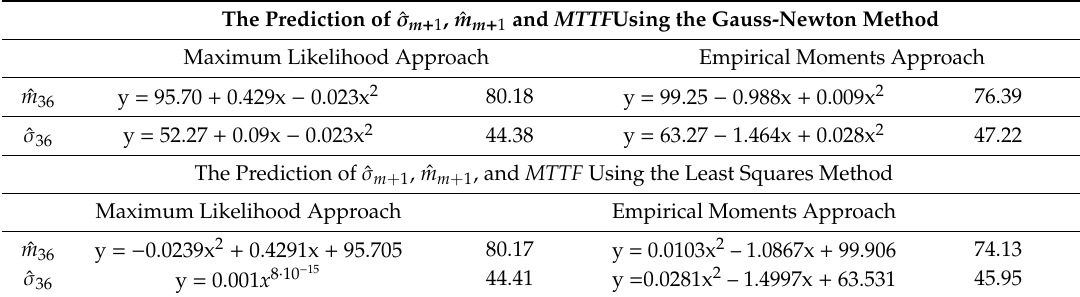
Table 2. Calculation of parameters ˆ m i , ˆ σ i and reliability characteristic mean time to failure ( MTTF). The Prediction of ˆ σ m + 1 , ˆ m m + 1 and MTTF Using the Gauss-Newton Method